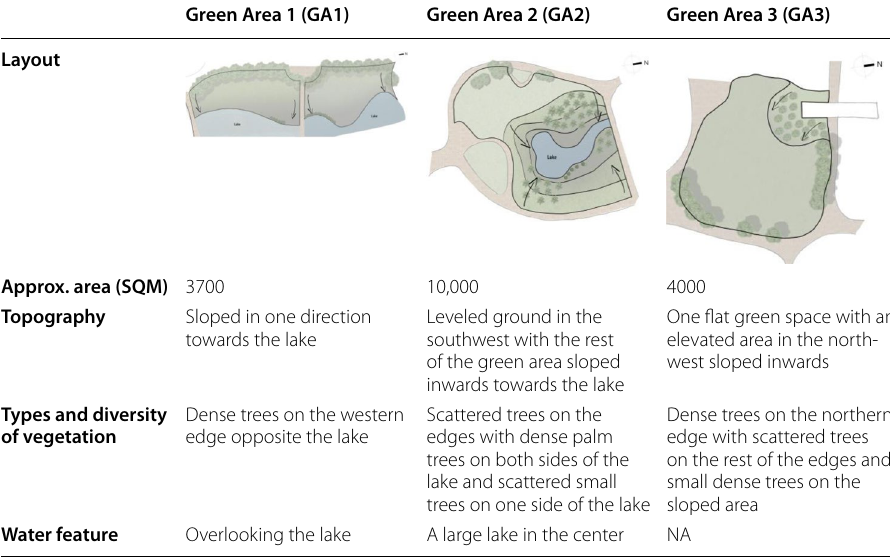
Table 1 Difference in physical characteristics of the three investigated green